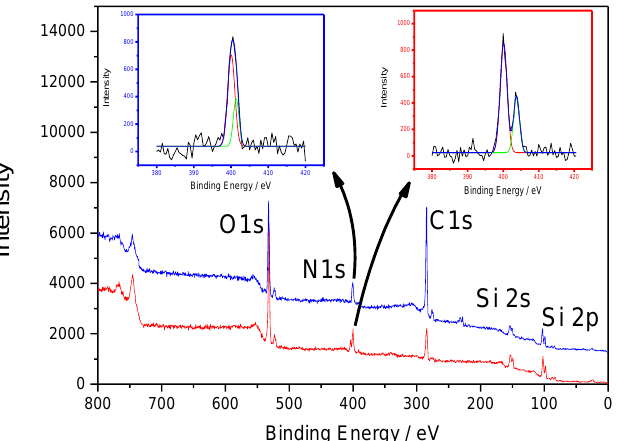
Figure 8. XPS spectra recorded on silicon nanowires modified with azide (red curve) and pyrene groups (blue curve) including enlarged spectra of N1s before and after click chemistry.